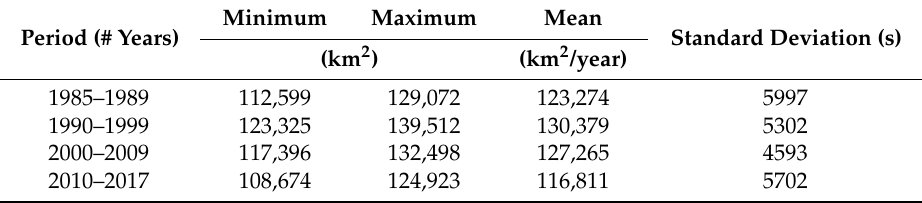
Figure 4. Annual surface water extent mapped with SWSC with Loess trend smooth pattern (red line) and 95% confidence interval ( A ). Box plot statistics are presented in ( B ) for circa decade periods. Table 1. Surface water mapping summary statistics estimated for decade periods.